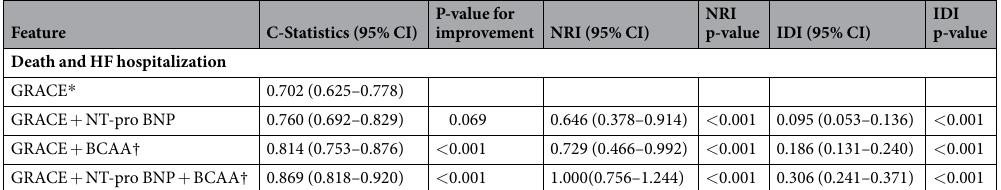
Table 3. C-statistics, NRI, and IDI for incremental predictive values of in-hospital cardiovascular death and acute heart failure following the sequential addition of NT-pro BNP and factor 2 to GRACE score. * GRACE risk score is derived from age, heart rate, systolic blood pressure, creatinine, Killip class, cardiac arrest at admission, presence of ST-segment deviation, and high cardiac enzyme concentrations. P values < 0.05 are relative to the GRACE risk model. CI = confidence interval; IDI = integrated discrimination improvement; NRI = net reclassification